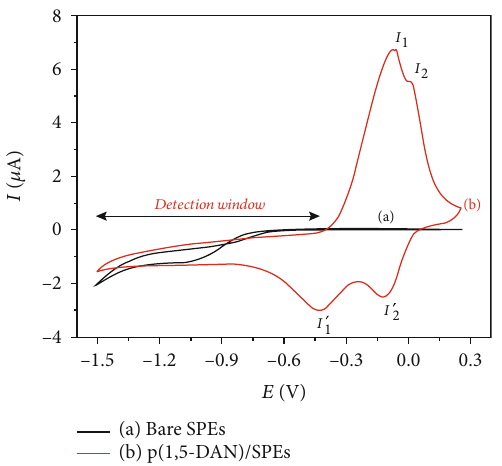
Figure 3: CVs of bare SPEs (curve (a)) and p(1,5-DAN)/SPEs (curve (b)) in 0.1M acetate bu ff er (pH4.5) with the scan rate of 50 mV · s -1